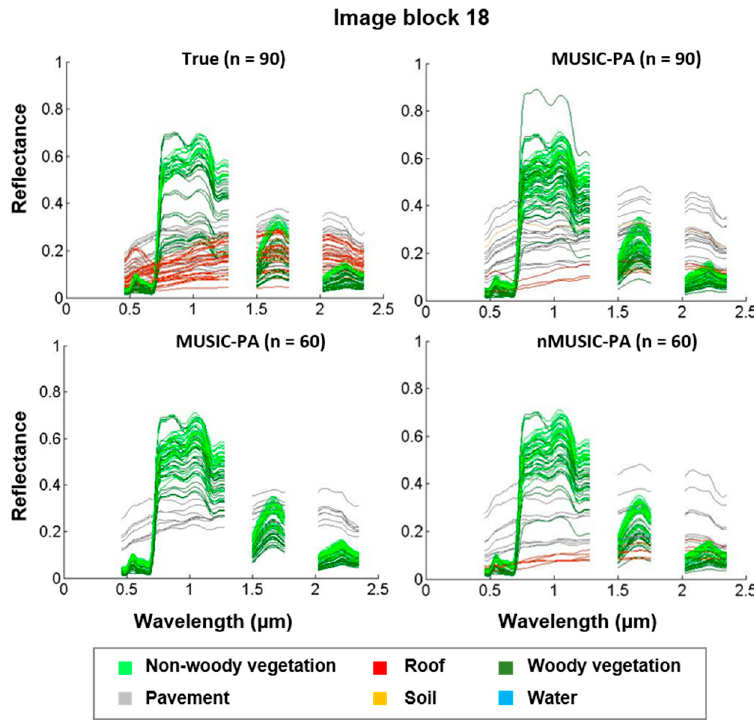
Figure 6. In case of image block 18, the original MUSIC-PA mainly selects vegetation spectra (upper right panel), whereas the image itself is mainly dominated by roof (illustrated by the true endmembers in the upper left panel). When decreasing the number of spectra in the final library size to 60 (lower left panel), no roof is selected at all, which would have severe implications on the subsequent mapping of this image. This panel also shows the brightness bias of MUSIC-PA, mainly selecting bright spectra. By applying brightness normalization (nMUSIC-PA, lower right panel), this bias is clearly reduced.